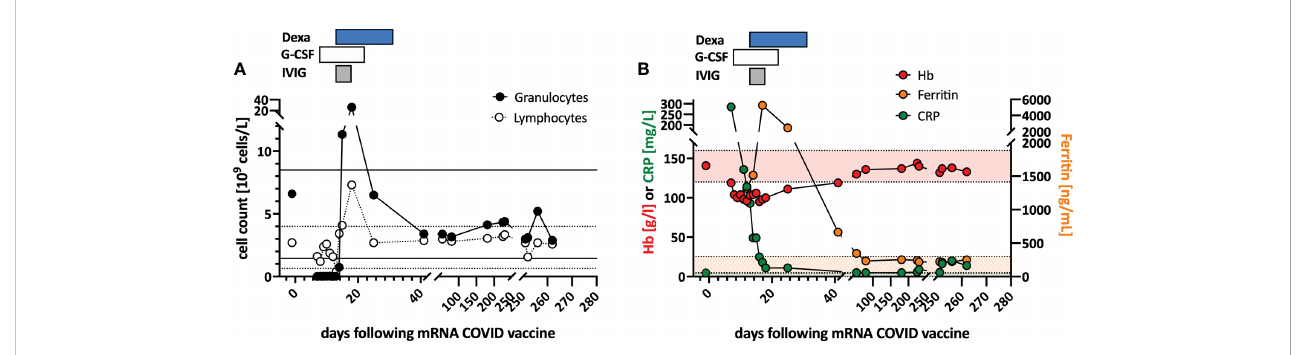
FIGURE 1 Clinical course and in vitro stimulation with mRNA-1273. (A) Longitudinal peripheral leucocyte and lymphocyte counts are shown. The black lines indicate the normal reference range of the granulocyte count, and the dotted lines the reference range for the lymphocyte count. (B) Longitudinal measurements of hemoglobin (red), c-reactive protein (CRP; green), and ferritin (orange) serum levels as markers of systemic in fl ammation are indicated. Shaded areas indicate the reference range for the markers (color coded). Treatments are indicated at the top of the graphs: DEXA, dexamethasone; G- CSF, granulocyte stimulating factor; IVIG, intravenous